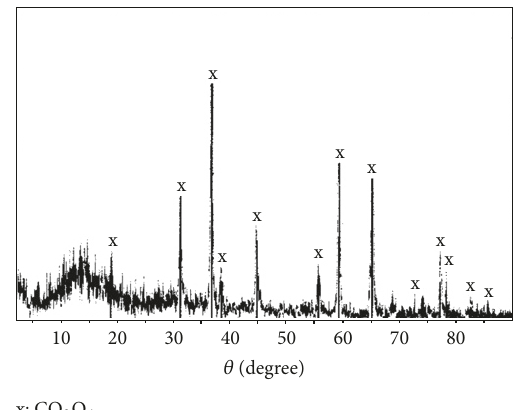
Figure 3: X-ray powder diffraction patterns of decomposition products of Co(mef) 2 ⋅ 2H 2 O heated up to 660 ∘